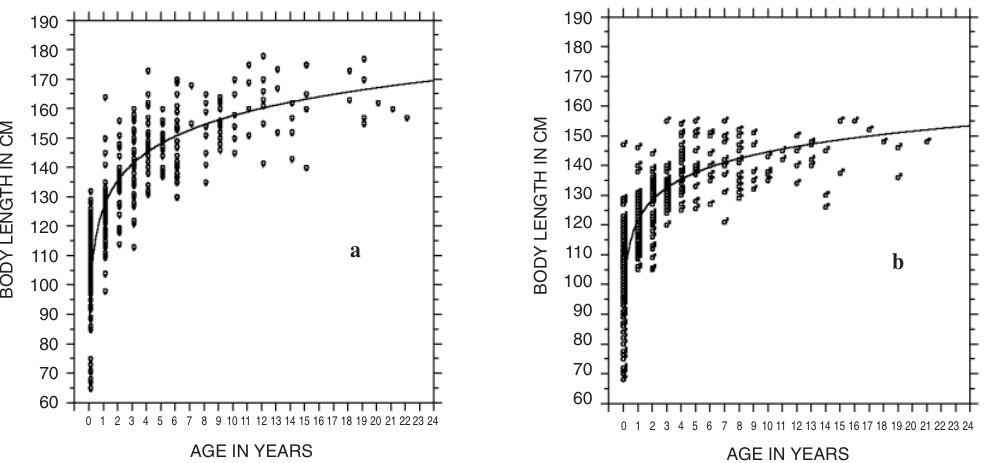
Fig. 5. Body length at age of porpoises from strandings and bycatches. a. females; b.